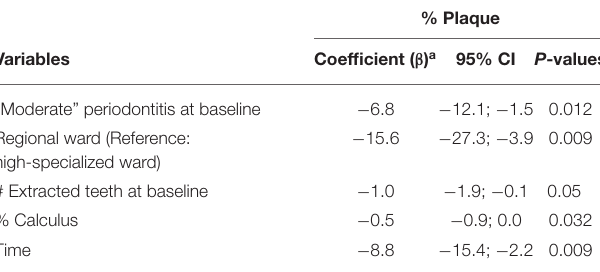
TABLE 3A | Mixed effect regression model comparing plaque and systemic findings.